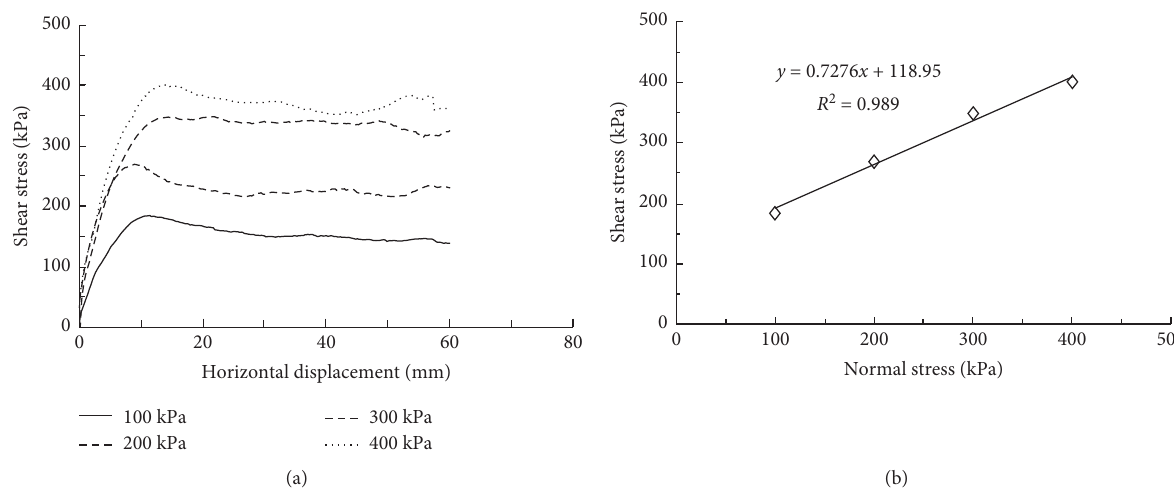
Figure 12: (a) Variation of shear stress with horizontal displacement obtained by direct shear tests on G2 with a plate opening of 10.0mm. (b) Failure envelope for G2 (plate opening 10.0mm).